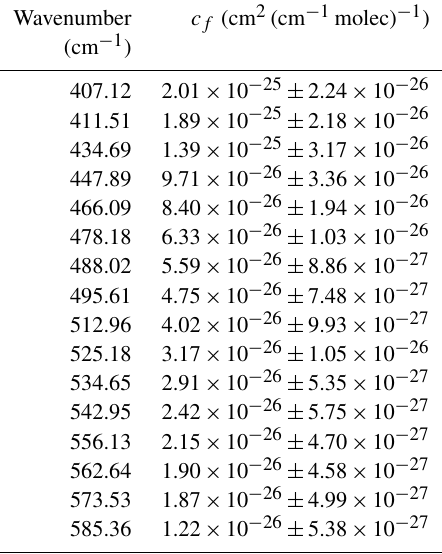
Table 3. Mean foreign-continuum coefficients derived from the Zugspitze closure measurements and associated (2 σ)